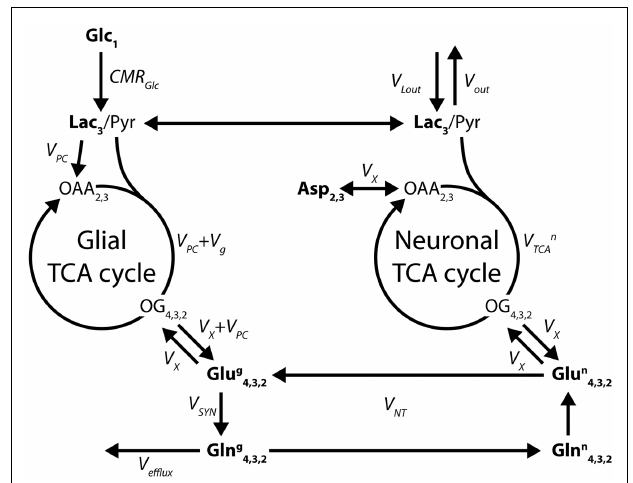
FIGURE 7 |Two-compartment model of compartmentalized brain metabolism, as proposed by Gruetter et al. (29). The model consists of the glial and neuronalTCA cycles, linked by the glutamate/glutamine cycle. Glc, glucose; Lac, lactate; Pyr, pyruvate; OAA, oxaloacetate; OG, oxoglutarate; Asp, aspartate; Glu, glutamate; Gln, glutamine.The system is characterized by the following fluxes: CMR Glc , cerebral metabolic rate of glucose; V PC , pyruvate carboxylase; V g glialTCA cycle rate; V X , transmitochondrial exchange; V n , neuronalTCA cycle rate; V SYN , glutamine TCA synthesis; V NT , apparent neurotransmission rate; V efflux , loss of glutamine from the glial compartment; V out and V Lout , label dilution and exchange of lactate across the blood-brain barrier.The indexes represent the labeled carbon positions. Boldface indicates NMR-measurable